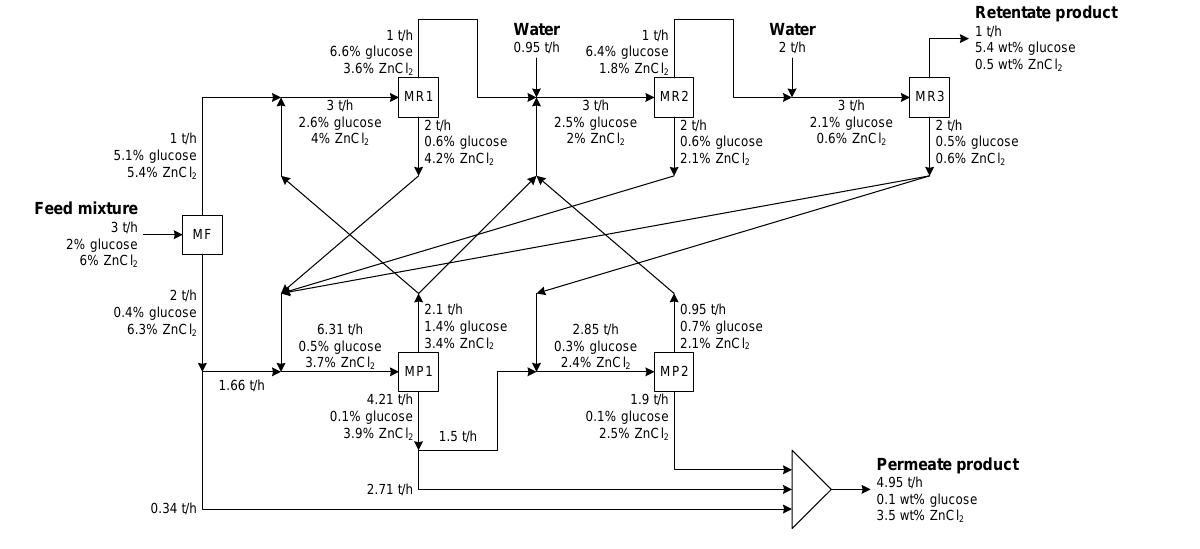
Figure 6. Optimal NF membrane network for case 2. Table 6. Flowrates between membrane units for case 2 (t/h). From MR Units to MP Units From MP Units to MR Units